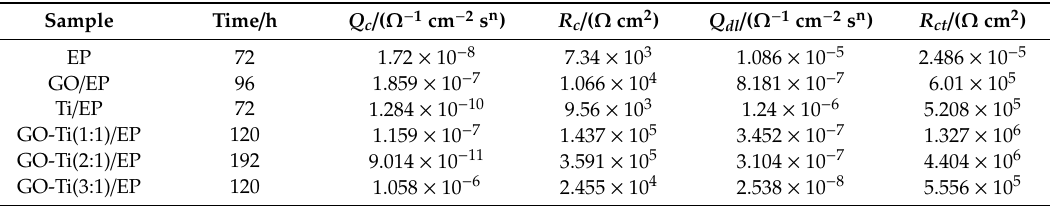
Figure 9. ( a ) Nyquist plots of coatings, ( b , c ) Bodes plots of coatings after soaking for 72 h (EP,Ti/EP), 96 h (GO/EP), 120 h (GO-Ti(1:1)/EP, GO-Ti (3:1)/EP) and 192 h (GO-Ti(2:1)/EP) and ( d ) The equivalent 96 h (GO / EP), 120 h (GO-Ti(1:1) / EP, GO-Ti (3:1) / EP) and 192 h (GO-Ti(2:1) / EP) and ( d ) The equivalent Table 1. The electrochemical parameters extracted from electrochemical impedance spectroscopy (EIS) data of the EP, GO / EP, Ti / EP, and GO from Table 1. GO-Ti(3:1) / EP and GO-Ti(2:1) / EP samples immersed in 3.5 wt % NaCl solution for di ff erent